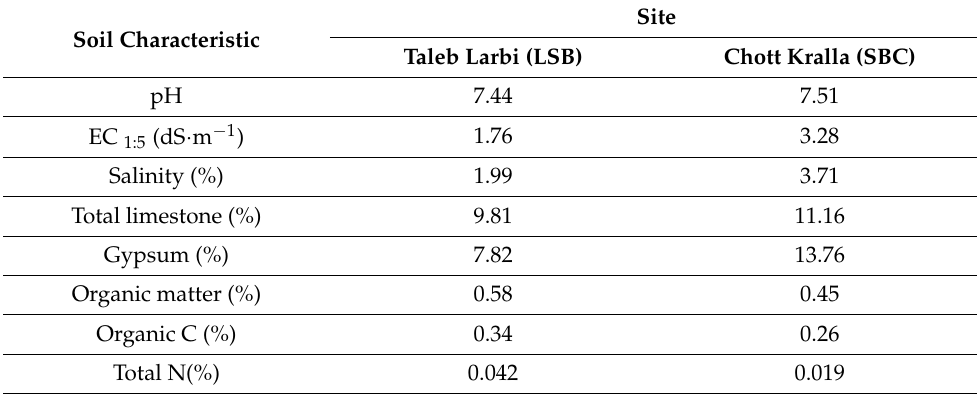
Table 1. Physicochemical soil properties. (SBC, Saline biocrusts; LSB, Less saline biocrusts). Soil